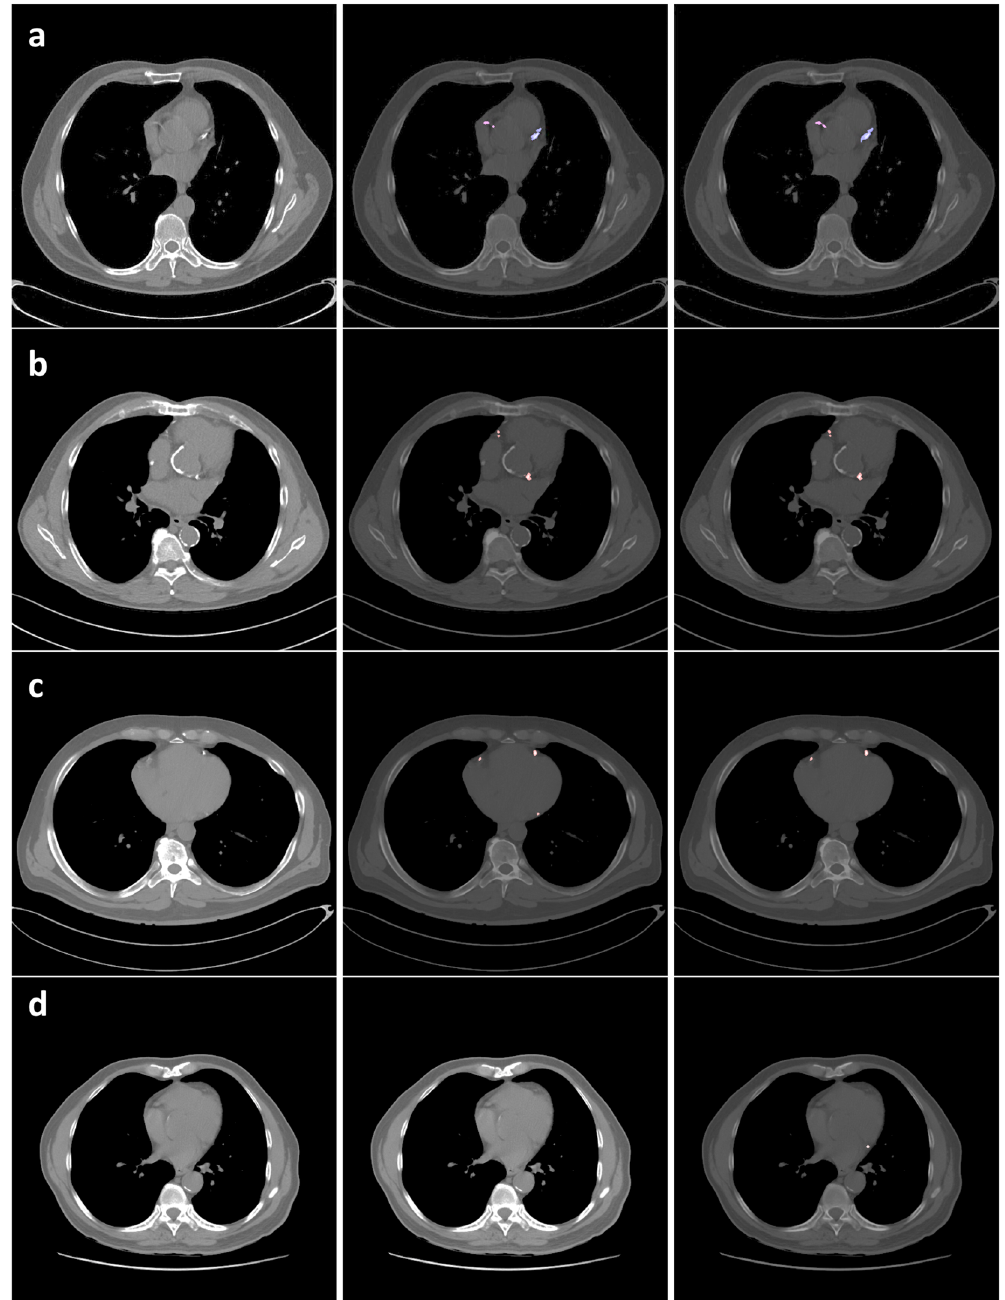
Fig. 7 CAC scoring case examples. Coronary artery segmentation (reference image on left, manual in middle; automated on right) in four different patients ( a – d ). Row a shows qualitatively similar performance between automated and manual methods of CAC scoring on non- gated chest CTs. Row b shows model prediction in a patient with signi fi cant aortic root calci fi cation. Note that the model does not misclassify this as CAC. Row c is an example of false negative prediction by the model in the left circum fl ex. Row d is an example of a false positive in the left circum fl